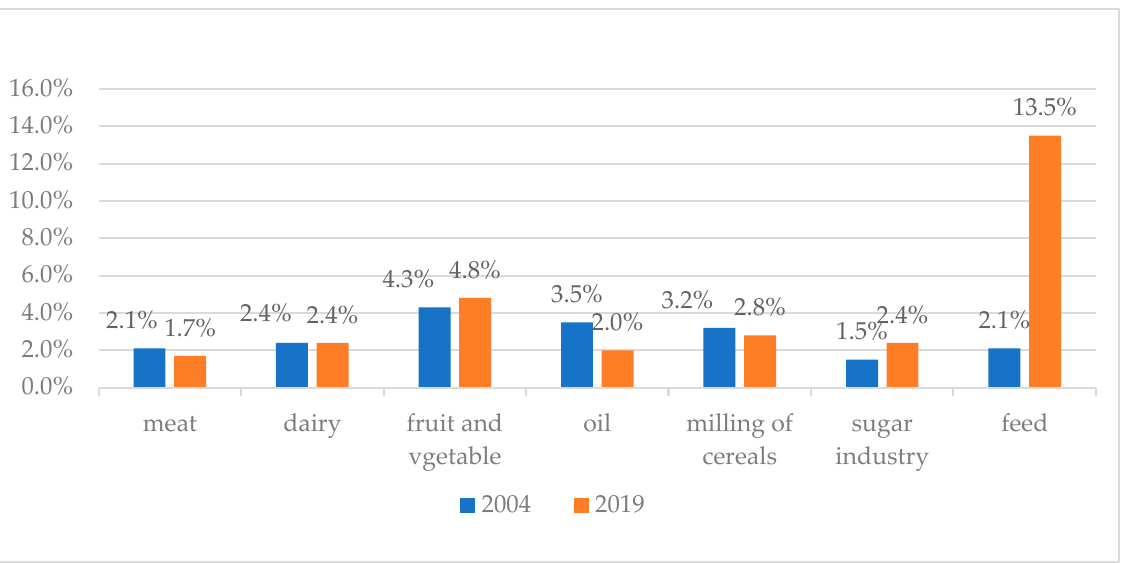
Figure 5. The share of electricity in the consumption of materials for production in selected branches of the food industry. Source: own elaboration based on unpublished GUS data, from F-01 financial statements submitted by food-industry companies.